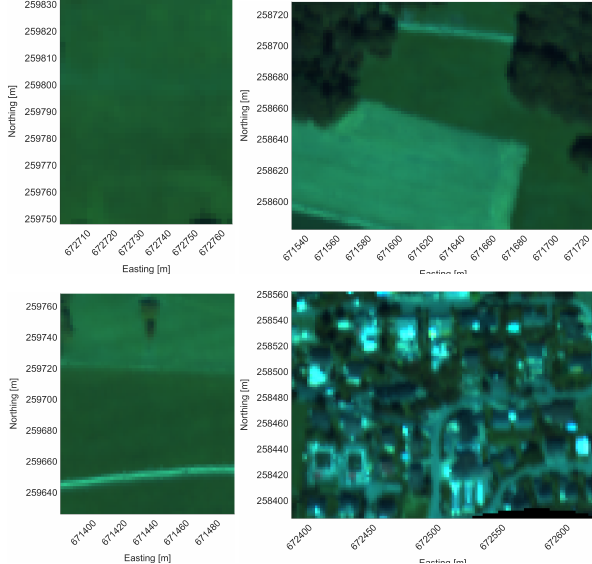
Figure 3: The four test areas in detail, shown as RGB true-color composite of the according HSI reflectances. Top left: test area 1, bottom left: test area 2. Top right: test area 3, bottom right: test area